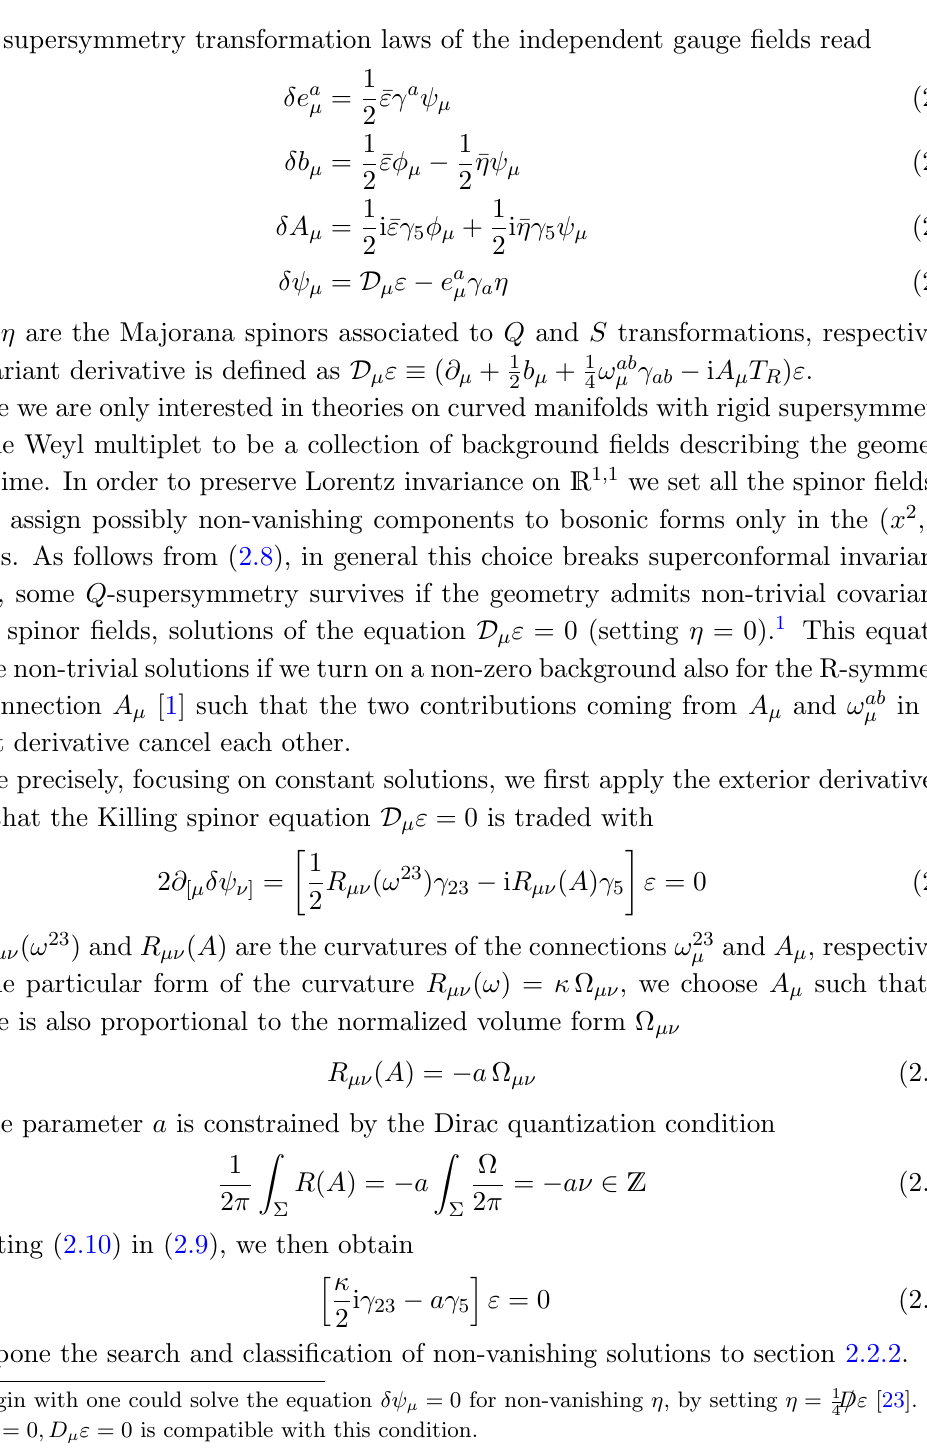
Table 1 . Generators and gauge (cid:12)elds of N = 1 conformal